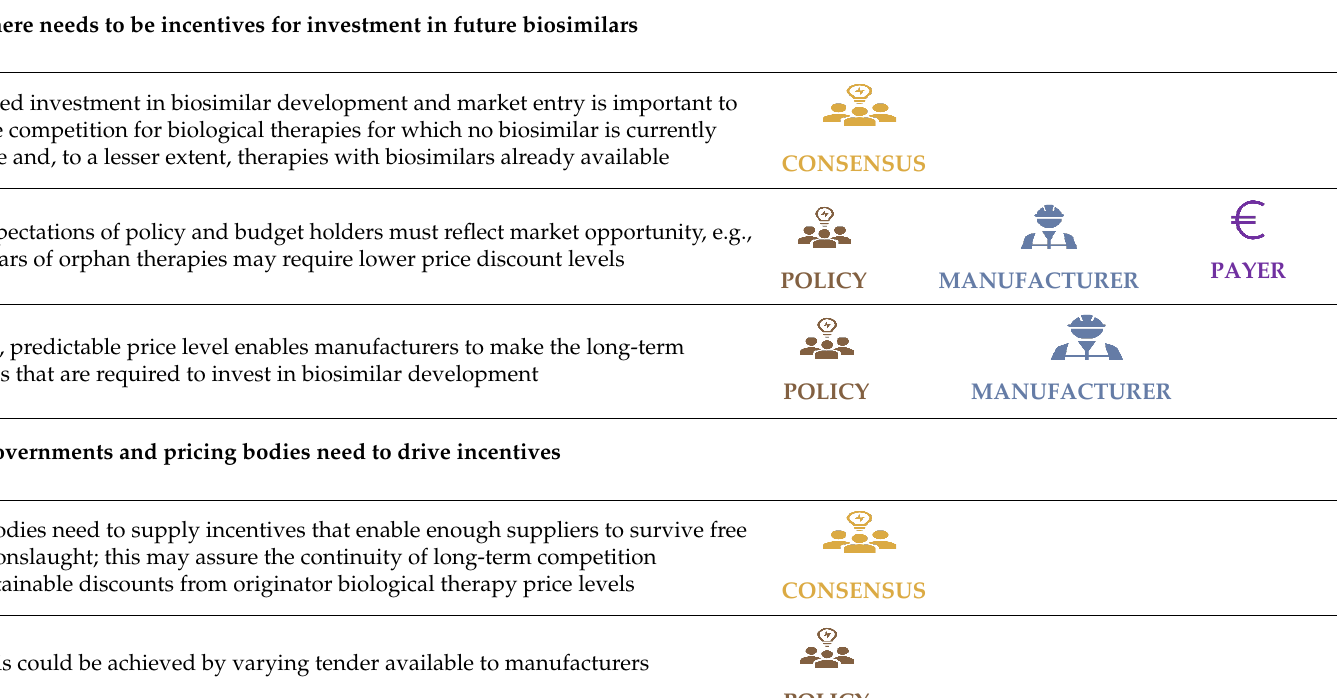
Table 1. Consensus on components of a sustainable biosimilar market.